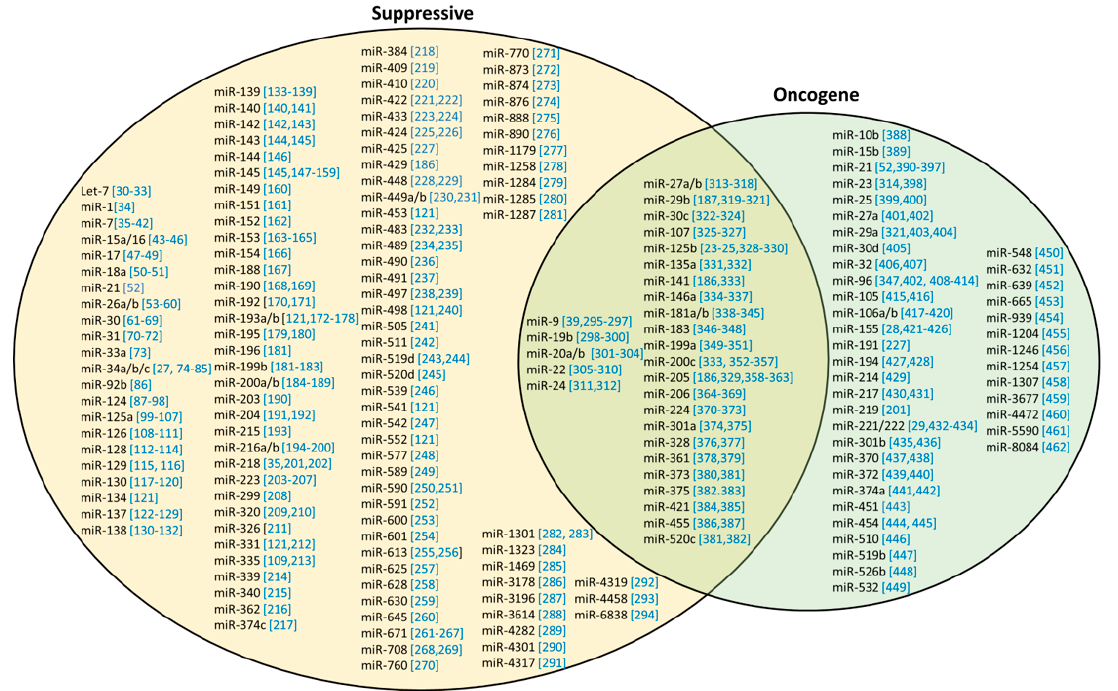
Figure 3. Roles of miRNAs. Summary of all the articles published from 2018 to 2020 in PubMed Database [30–462], using the search engine with the keywords “breast cancer” and “miRNA”. The articles that are relevant for the discussion in this review are included. The functions of miRNAs are divided into 3 categories: tumor suppressive (beige circle), oncogenic (green circle), or both (beige/green circle). The majority of the miRNAs fall under tumor suppressive.